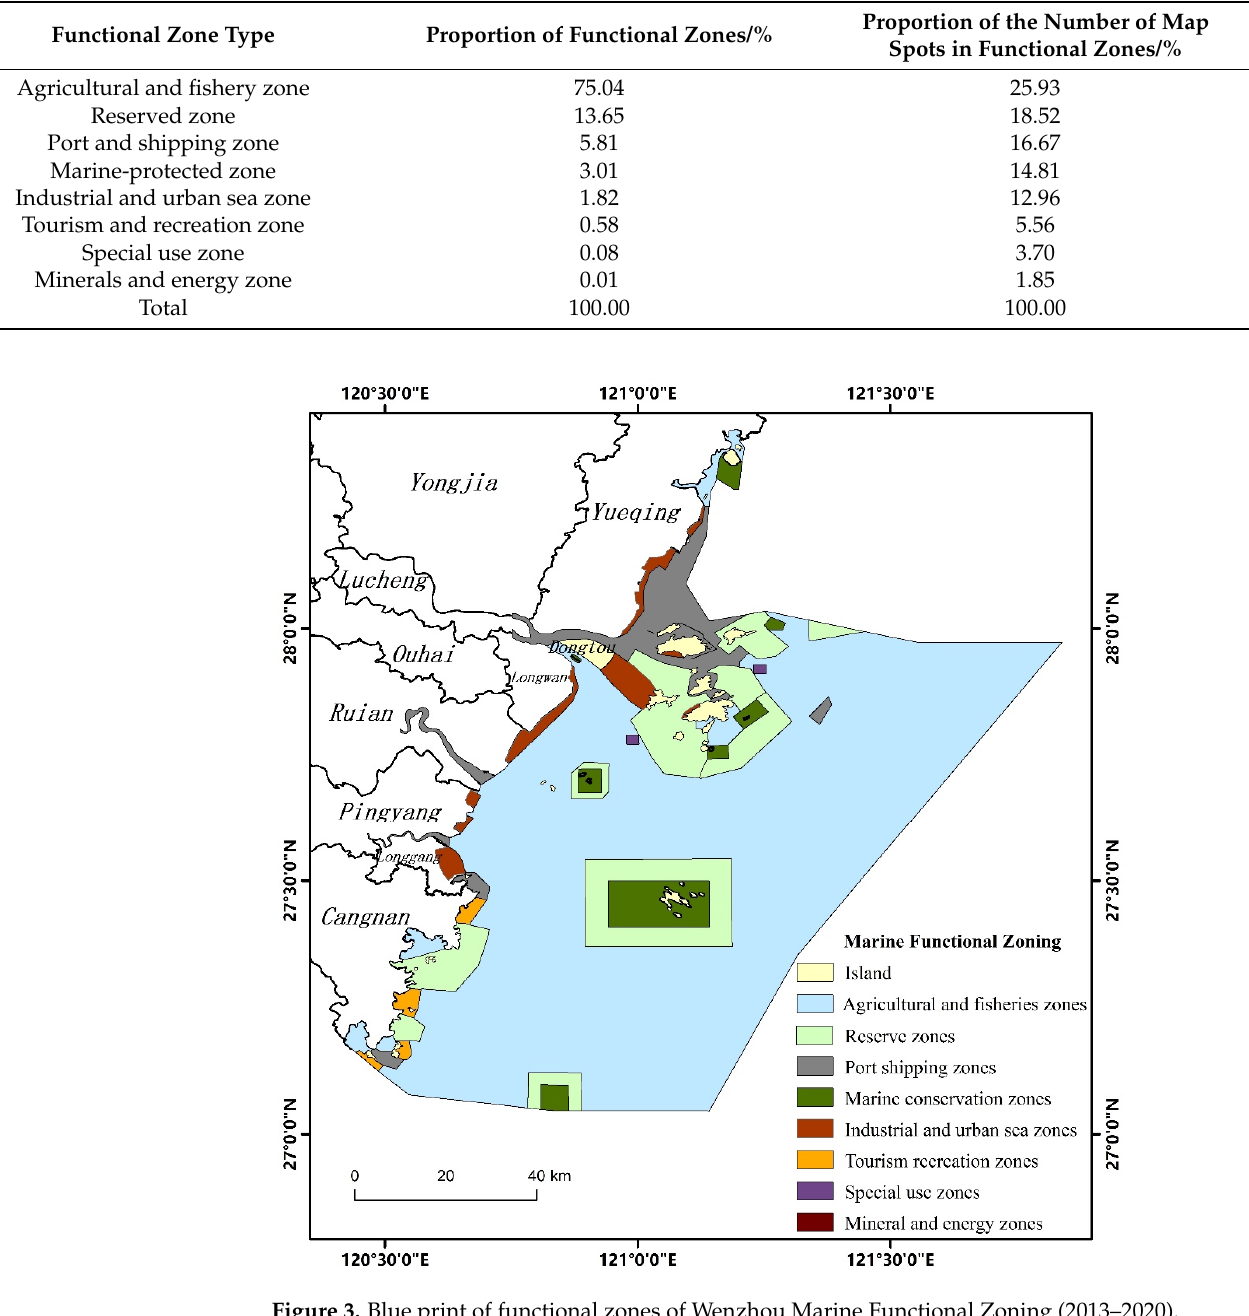
Figure 3. Blue print of functional zones of Wenzhou Marine Functional Zoning